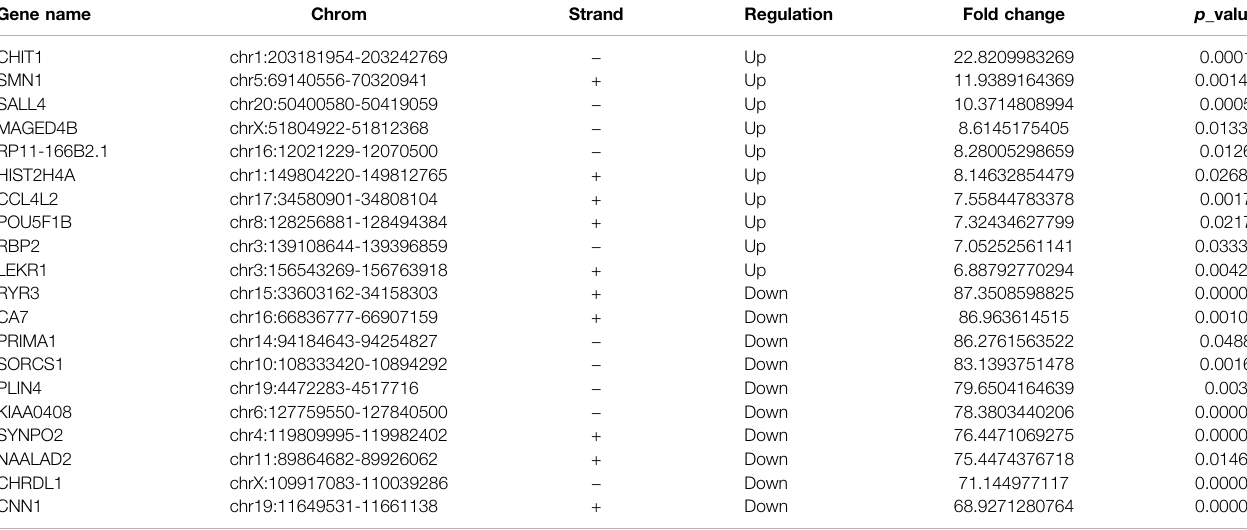
TABLE 2 | The top 10 upregulated or downregulated